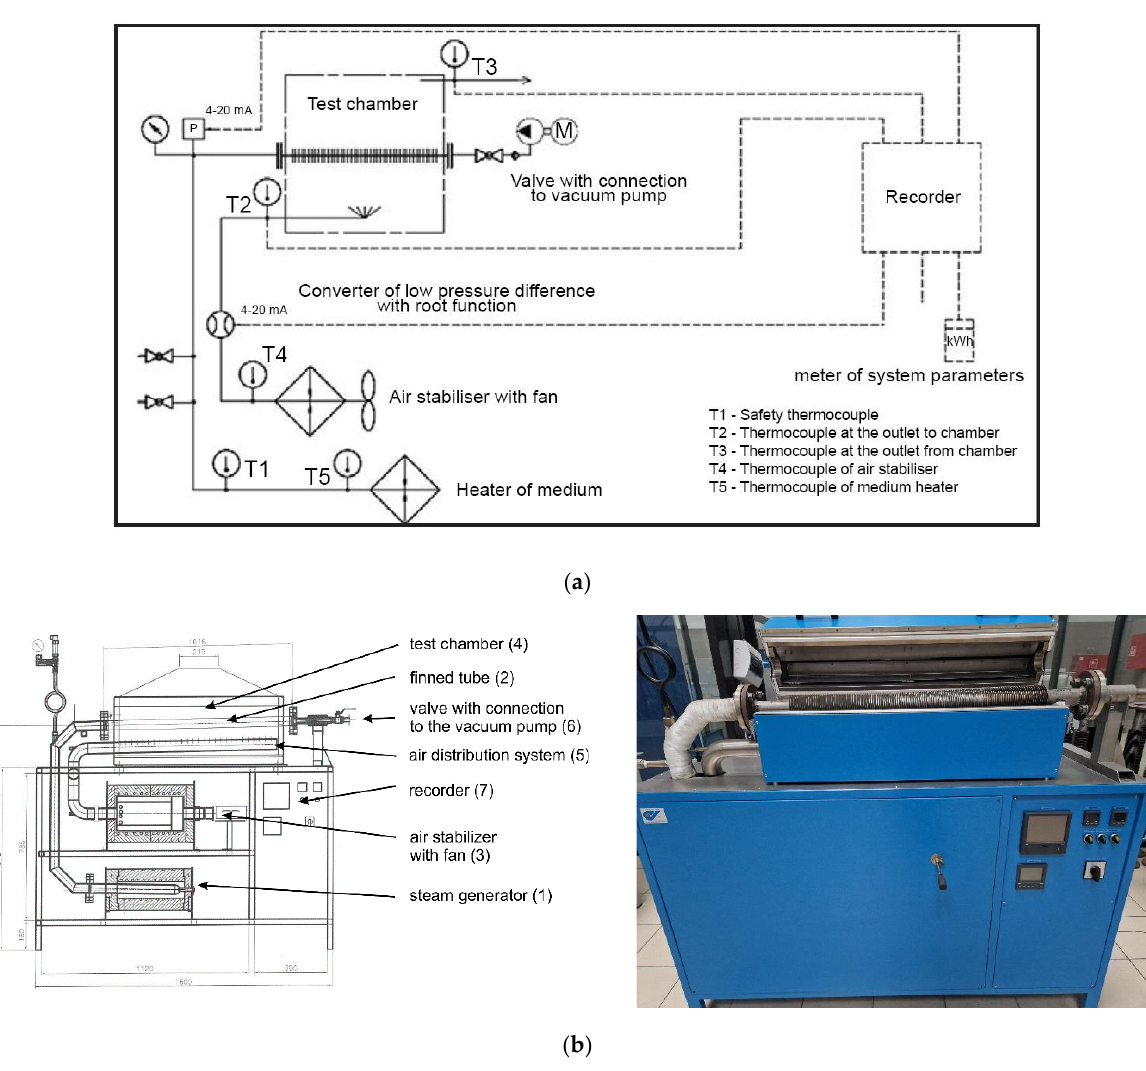
Figure 3. Diagram of the dedicated test stand for measuring the thermal performance of finned tubes: ( a ) conceptual design and ( b ) actual test stand built at Energoinstal SA, Poland.